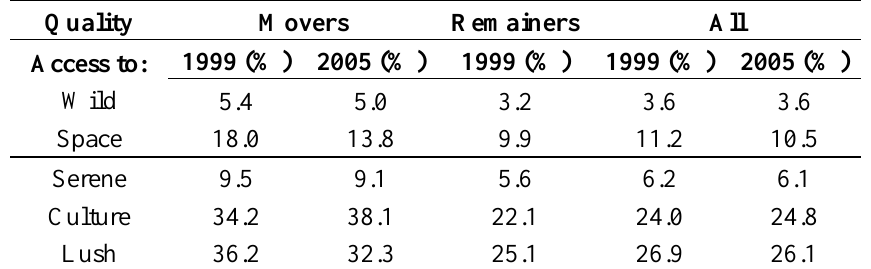
respective group had access to within the buffer zone. Table 2. Percentage of the population with access to each quality respectively (within 300 m) at baseline and at follow-up among “movers” and “all”. Baseline values for remainers (no change in values over